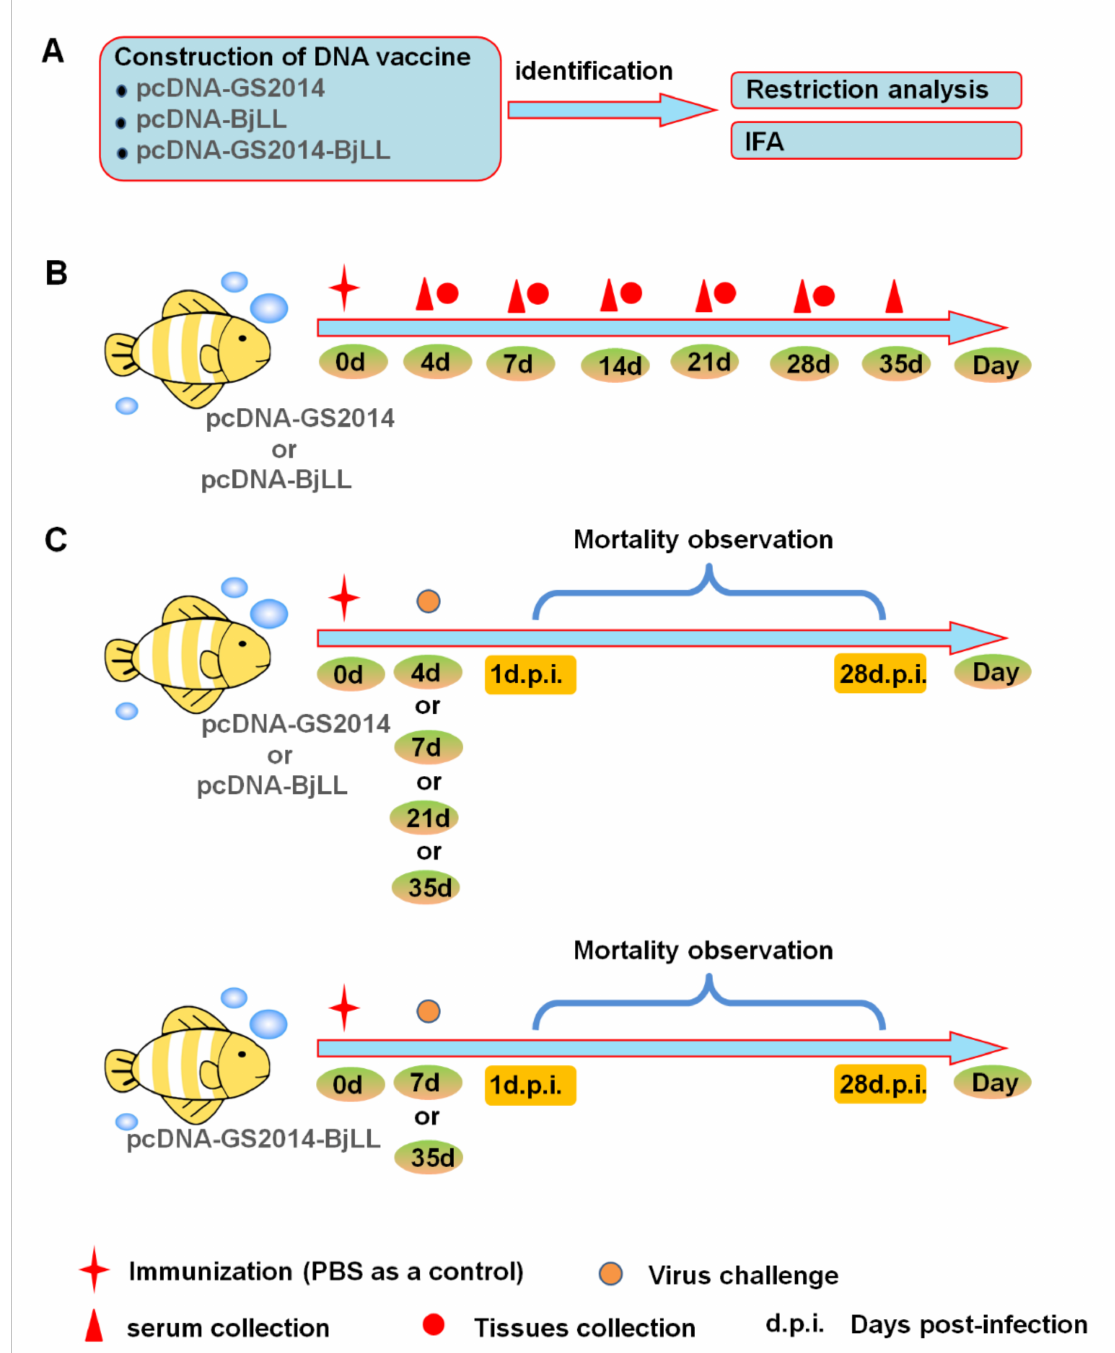
Figure 1. Experimental design schematic. ( A ) Three DNA vaccines were constructed by cloning the G gene of IHNV isolates GS2014 (genogroup J), BjLL (genogroup U) into the pcDNA3.1 vector, and a bivalent vaccine of pcDNA-GS2014-BjLL. Constructed DNA vaccines were identified by PCR and restriction analysis as well as IFA. ( B ) Rainbow trout were immunized with two DNA vaccines at dose of 1 µ g, and then the spleens and muscles of the injection site were collected at days 1, 4, 7, 14, 21, and 28 after immunization. In addition, serums were collected at days 1, 4, 7, 14, 21, 28, and 35 after immunization. ( C ) Rainbow trout were challenged with BjLL or GS2014 at days 4, 7, 21, and 35 after immunization of pcDNA-BjLL or pcDNA-GS2014. In addition, rainbow trout were challenged with BjLL or GS2014 at days 7 and 35 after immunization of pcDNA-GS2014-BjLL, respectively. The morbidity and mortality of rainbow trout were observed and recorded during 28 days after